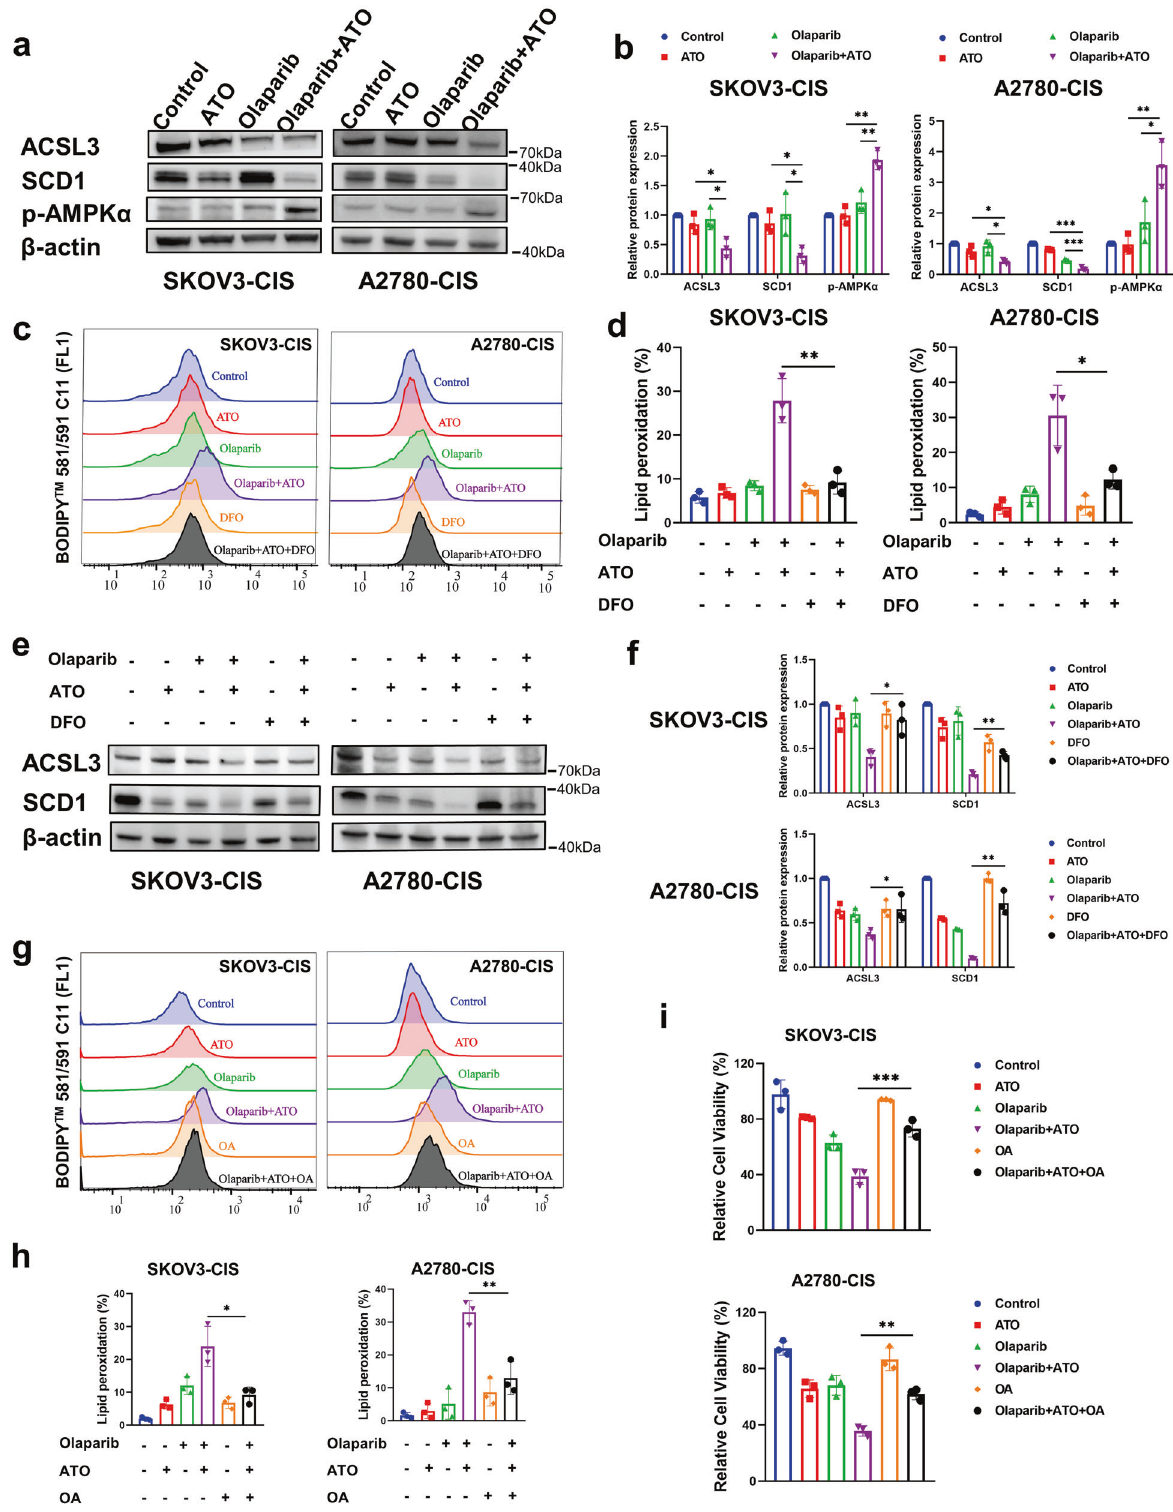
Fig. 5 Combined treatment of olaparib and ATO triggered ferroptosis by activating AMPK α -SCD1 signaling. a , b Western blot to analyze the protein changes of ACSL3, SCD1, and p-AMPK α caused by the combined treatment. The protein expression levels were normalized with β -actin. The normalized value of the control group was set to 1. c – f Relative lipid peroxidation levels ( c , d ) and protein expression levels of ACSL3, SCD1 ( e , f ) in SKOV3-CIS and A2780-CIS cells following treatment of olaparib and/ or ATO in the presence or absence of 10 μ M DFO. g – i Relative lipid peroxidation levels ( g , h ) and cell viability ( i ) in SKOV3-CIS and A2780-CIS cells following treatment of olaparib and/or ATO in the presence or absence of 50 μ M OA. Error bars are shown as mean ± SD from three independent repeats.